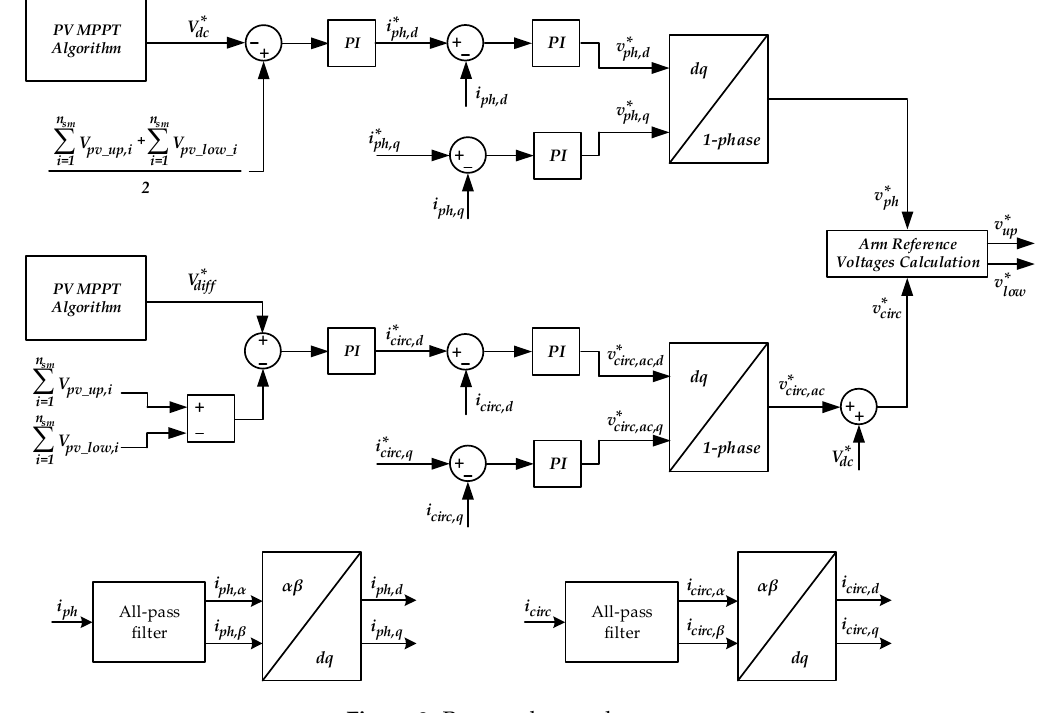
Figure 3. Proposed control structure.